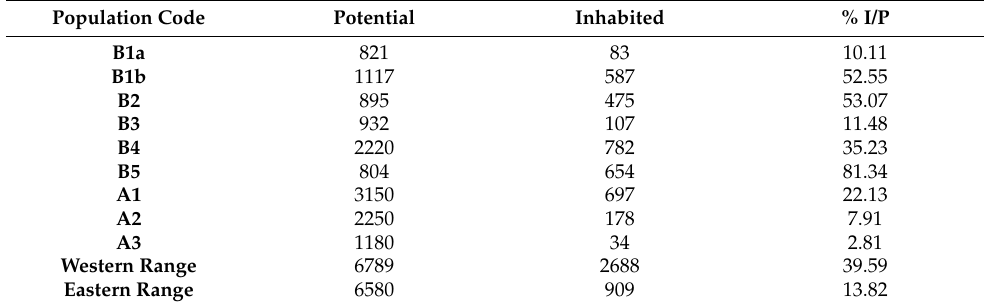
Table 3. Length of the streams where wild populations of Montseny brook newt were located. Potential: potential inhabited total length of stream (in m). Inhabited: Estimated inhabited lengths (in meters). I/P: percentage of occupied length (indicator of relative stream occupancy). A codes: Eastern populations. B codes: Western